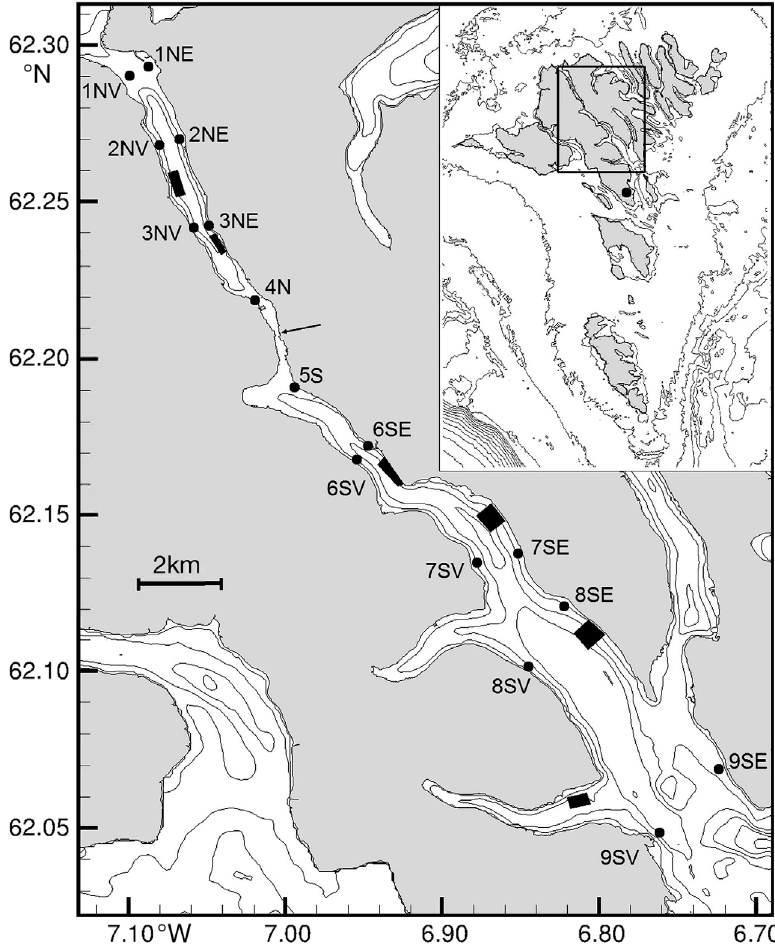
Fig. 1. Sampling stations ( d ) and salmon farming areas (black blocks). The arrow points out the narrow and shallow sill that divides Sundalagið into 2 main basins. N, S, E, V: stations located in the northern and southern basins, and in the eastern and western shores, respectively; isobaths for every 20 m depth; inset: location of the study area in relation to Faroe Islands (with 50 m isobaths); ( d in inset): the weather station